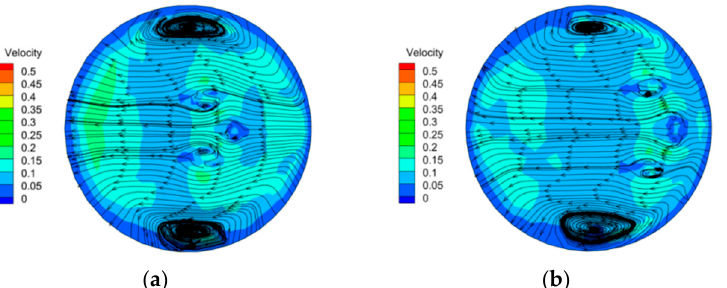
Figure 10. Streamline and velocity distribution of N1 section before and after optimization. ( a ) Before optimization. ( b ) After optimization.